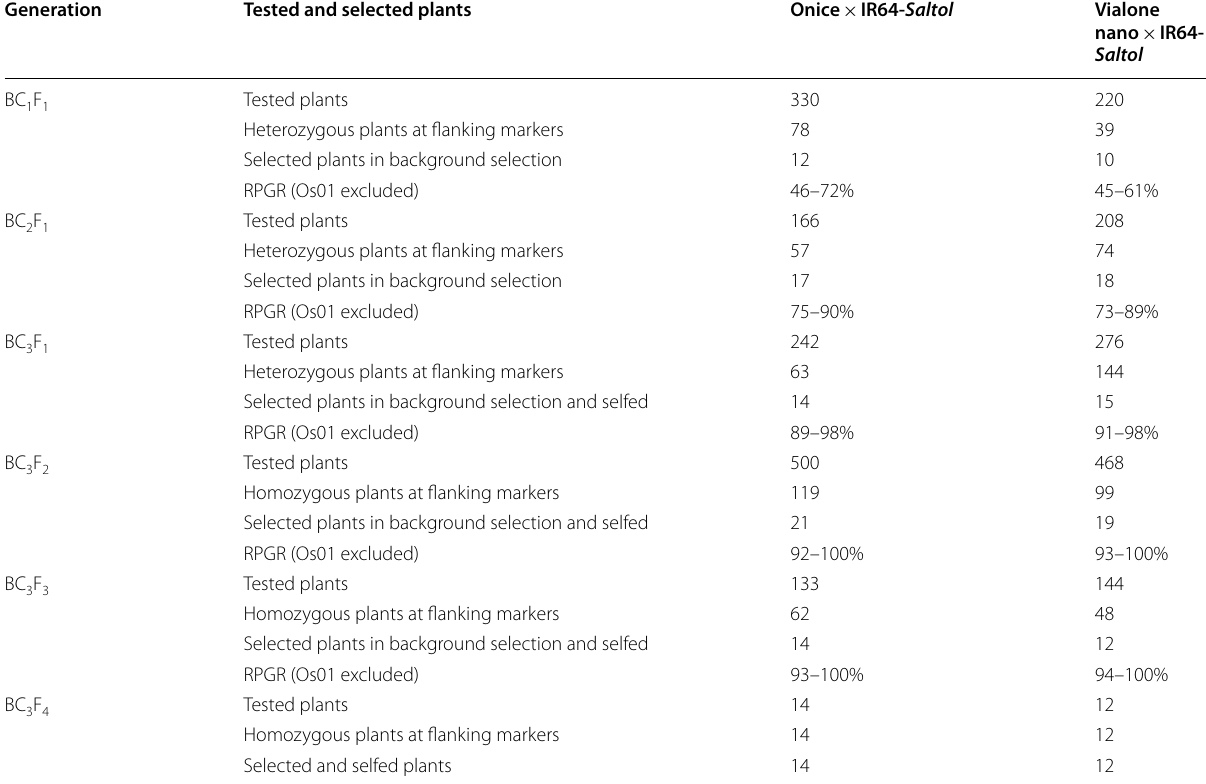
Tested plants indicate the number of analyzed plants, heterozygous/homozygous plants at flanking markers indicate the number of plants selected in foreground selection that have the marker alleles flanking Saltol locus in heterozygous or homozygous condition. RPGR% KASP markers)* 100